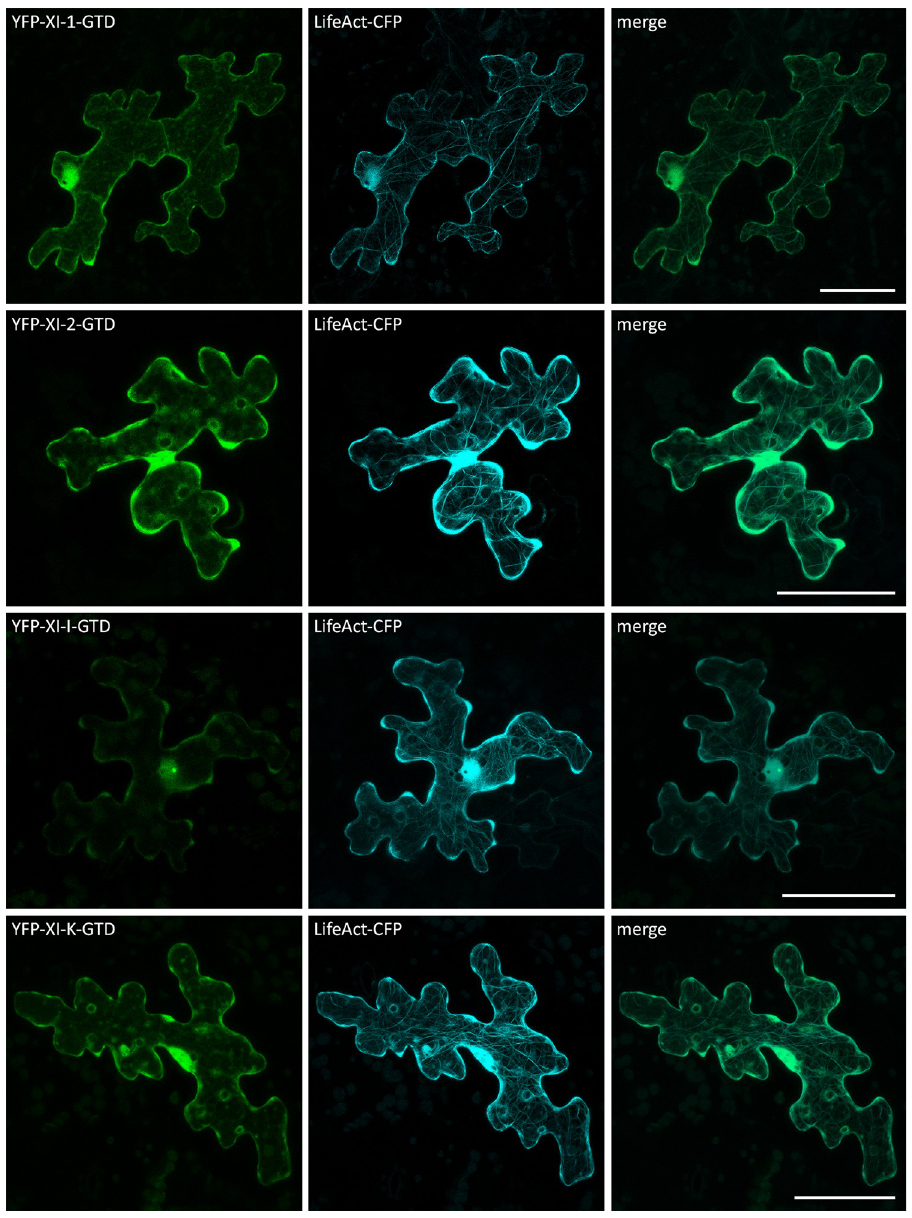
Fig 5. Co-localization of myosin GTDs and LifeAct in Arabidopsis epidermal cells. Transient expression of LifeAct-CFP with myosin GTDs in Col-0 epidermal pavement cells. The scales display 50 μ m.